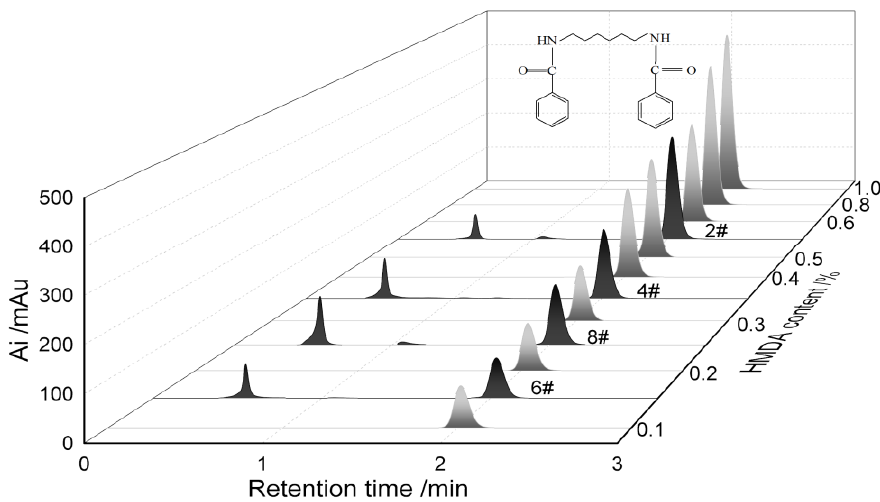
Figure 4. The liquid chromatography of the filtration and standard HMDA solution.